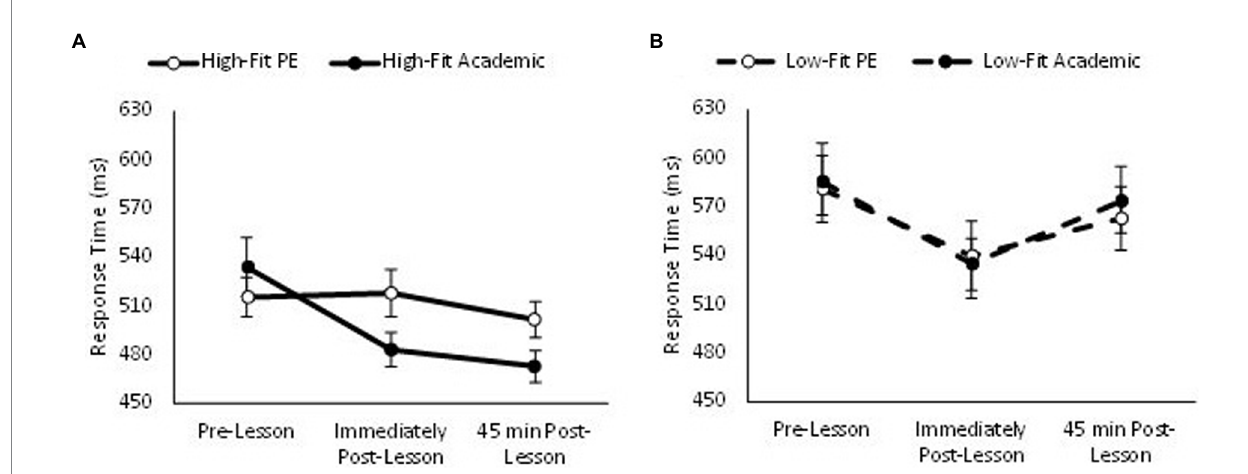
FIGURE 2 Response times across the morning on the one item level of the Sternberg paradigm on the PE and academic lesson trials for the high-fit (trial * time, p = 0.001; A ) and low-fit (trial * time, p = 0.746; B ) groups (trial * time * fitness, p =